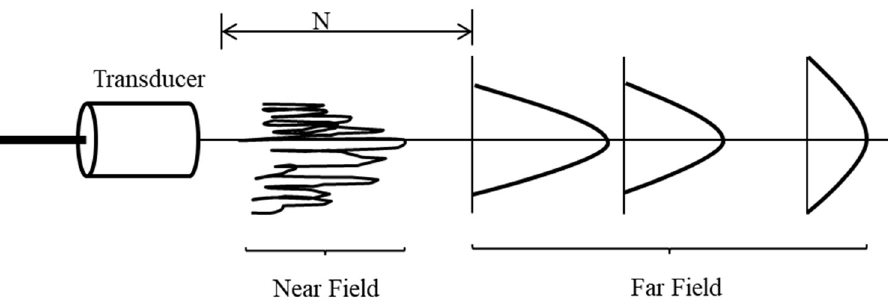
Figure 1. Beam profile with different distances.